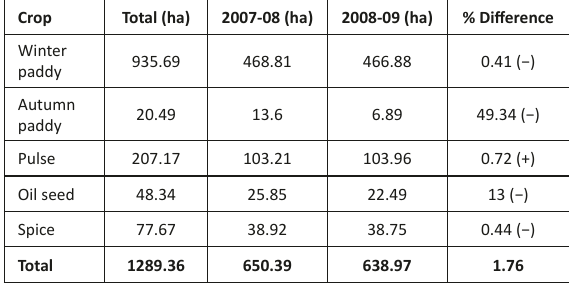
Table 2 The extent of cultivation of different crops recorded during study